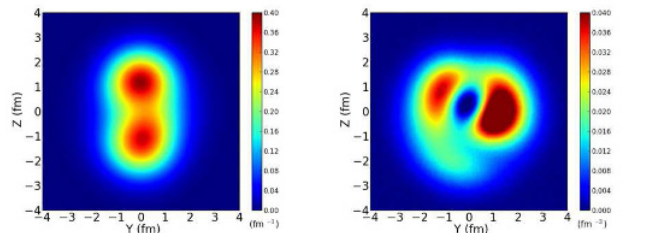
Figure 2. The densities of the 0 + ground state for 10 Be are shown. The number of basis states is N b = 100. The model space and harmonic oscillator energy are N shell = 4 and ~ ω = 25 MeV, respectively. The intrinsic densities for matter and valence neutrons are shown (left and right figures,